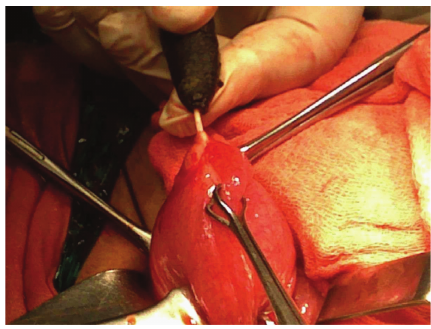
Figure 2: The stone was partially impregnated into the bladder musculature by virtue of the horizontal limb of the device.